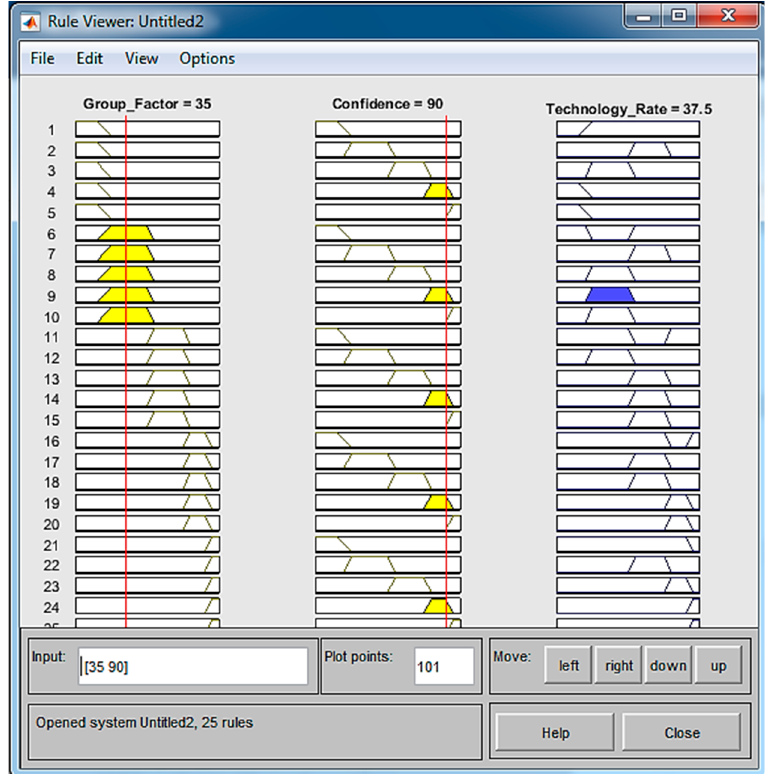
Figure 15. The estimation of the technology rate (current technology = 35; confidence =